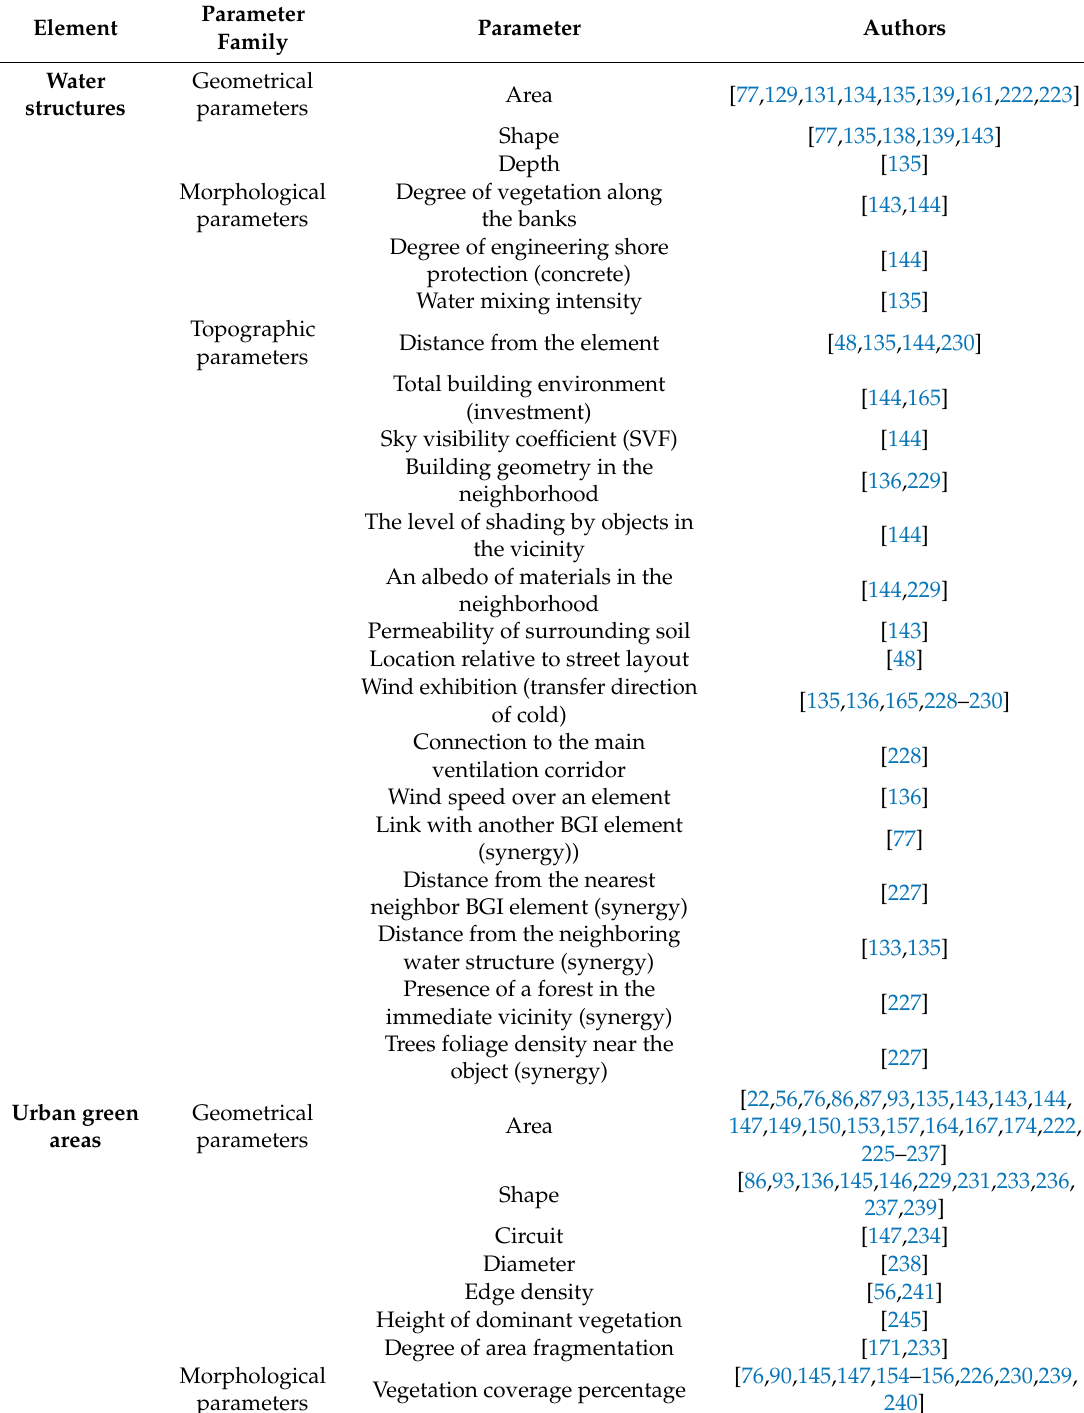
Table A1. Designing parameters of the blue-green infrastructure (BGI) elements affecting the Urban Heat Island (UHI) mitigation in warm temperate climate zone.